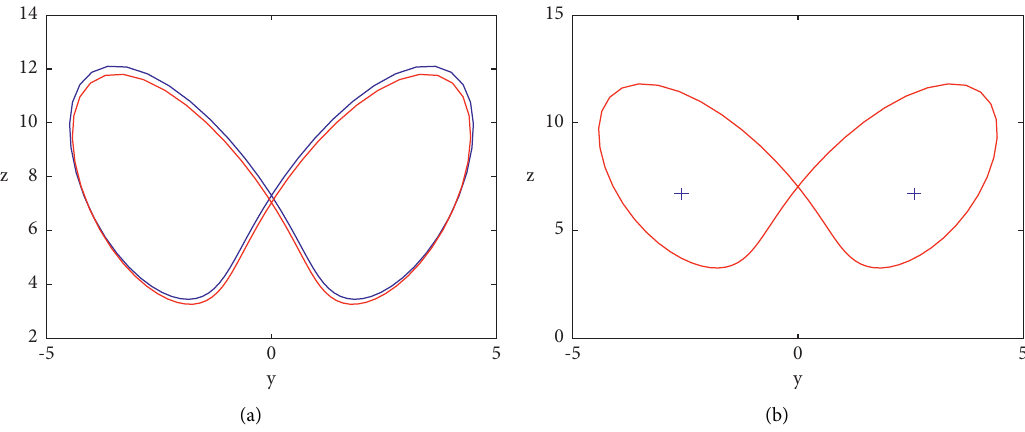
Figure 6: (a) Shortest unstable periodic orbit in the Rucklidge system for ( a,b ) � ( 2 , 6 . 7 ) . The blue line represents a loop conjecture, and the red line represents a real cycle. (b) Projection of cycle 01 and the locations of two equilibria, which are marked as “+”.